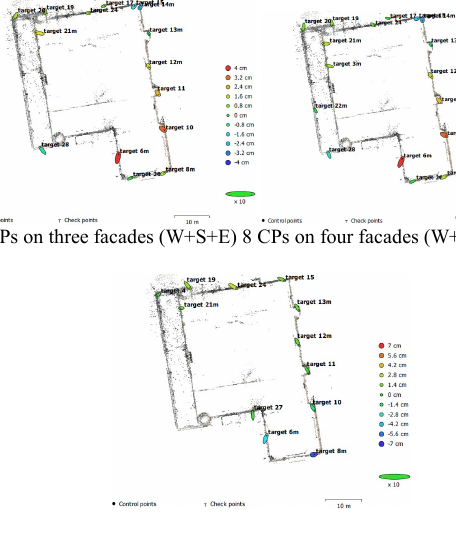
Fig. 4. The residuals on CPs and ChPs in loop close imaging (W:West, S: South, E: East, N: North)